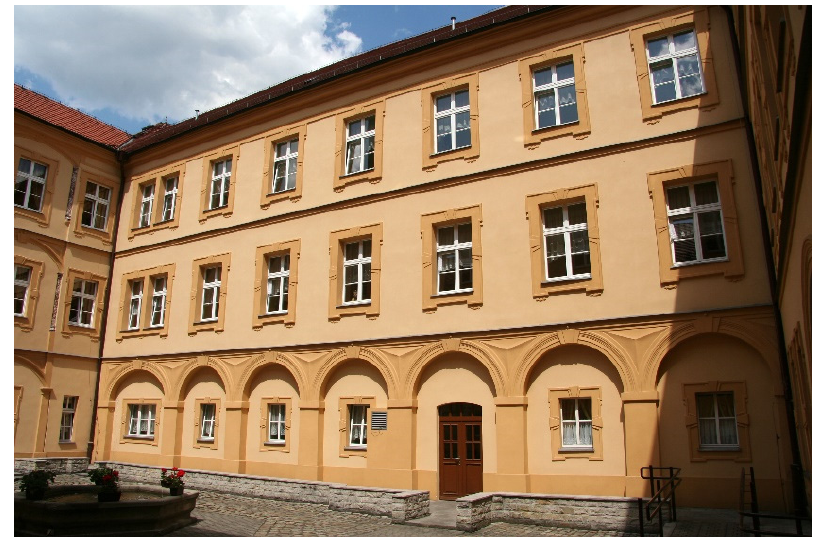
Figure 6. Prószków castle, courtyard, view from the south–east; photo by the authors . Figure 6. Pr ó szk ó w castle, courtyard, view from the south–east; photo by the